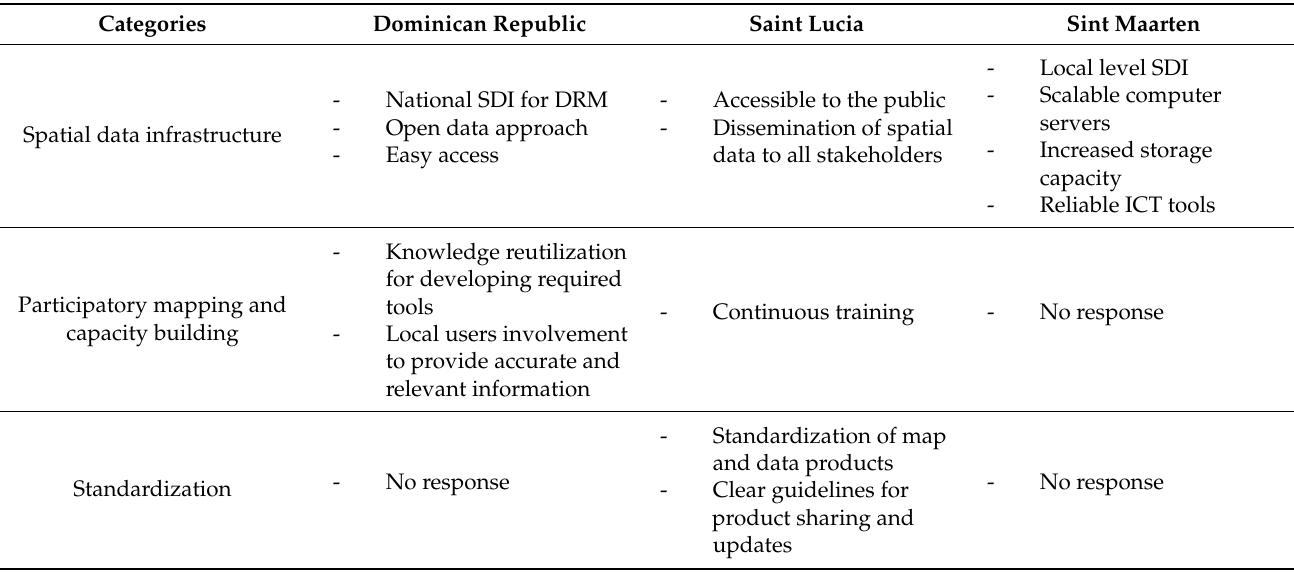
Table A5. Recommendations for EMT products sharing and continuous updates